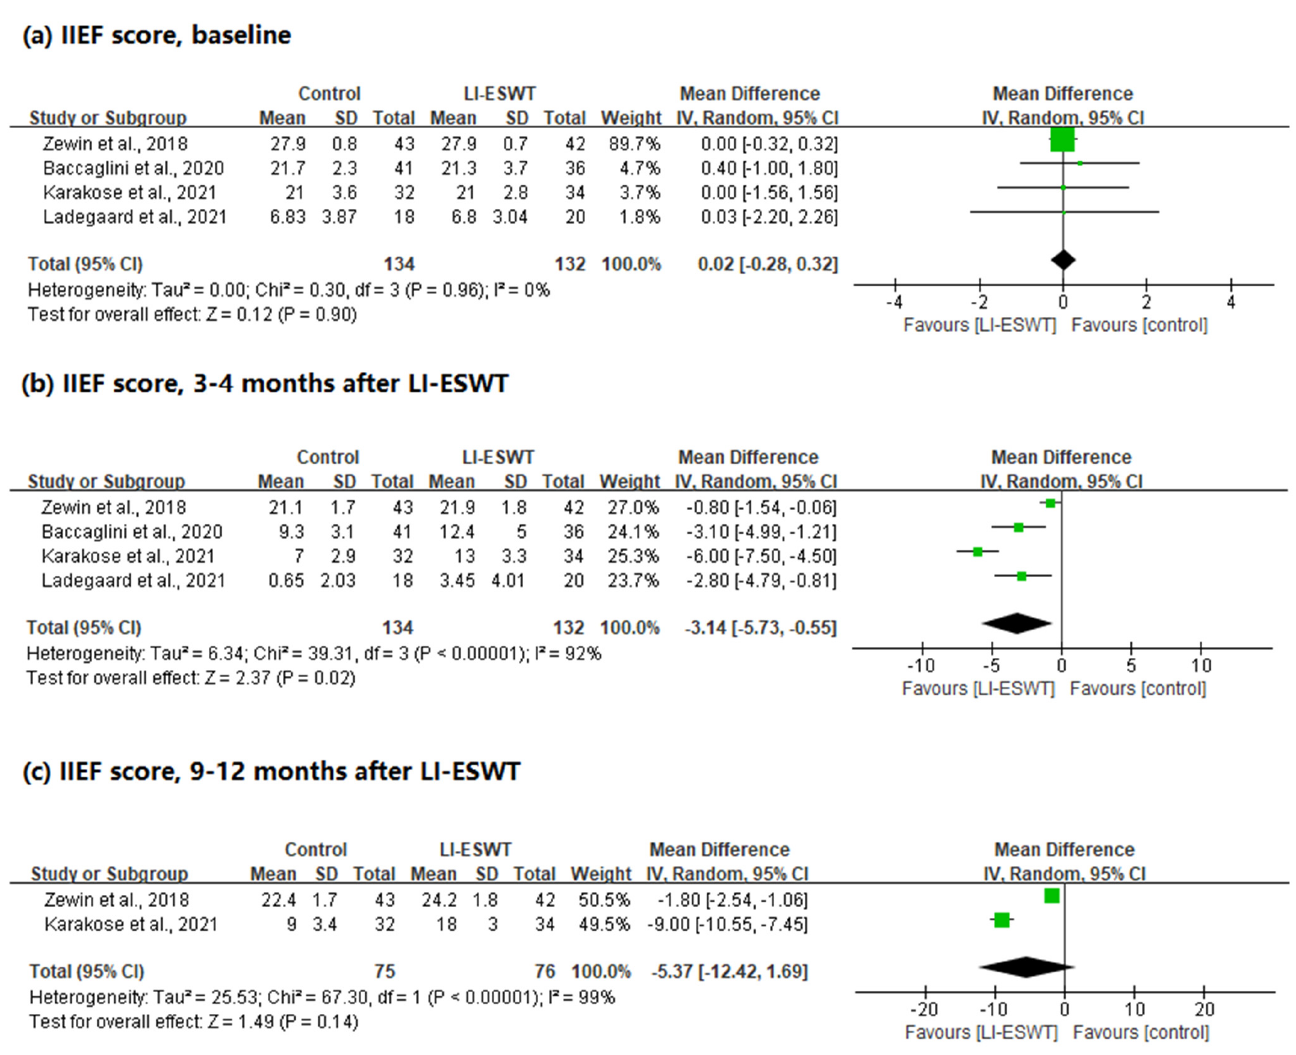
Figure 2. Forest plots for the change in IIEF scores after LI-ESWT (RCT studies).